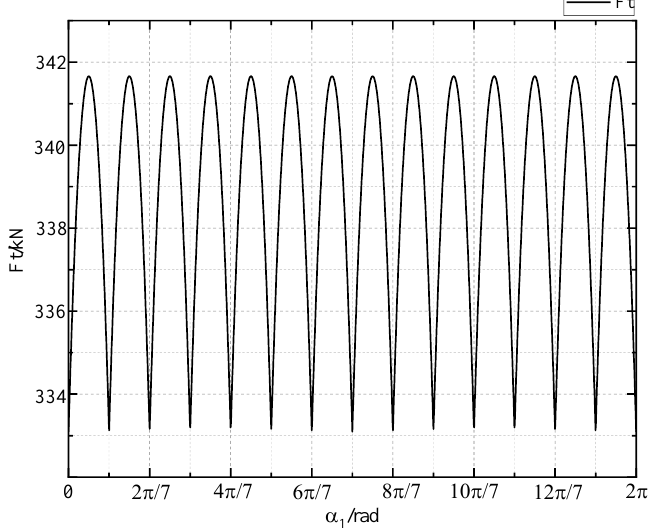
Figure 6. Diagram of the tangential force of the gear.